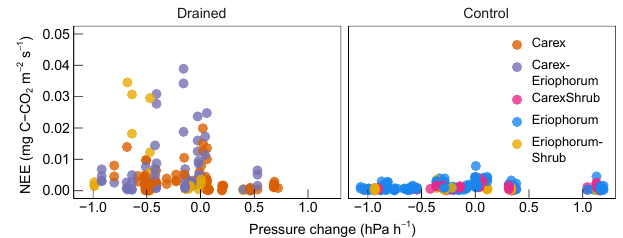
Figure 9. Change in P a and NEE from November 2013 by vegeta- tion type. Changes in P a refer to changes within 6h before individ- ual NEE was